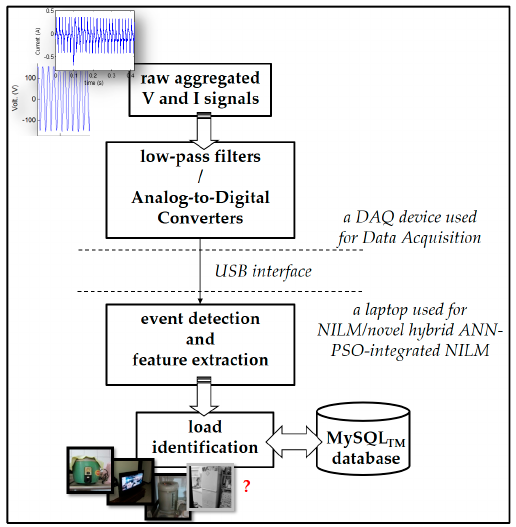
Figure 3. Workflow of the innovative hybrid ANN-PSO-integrated NILM used in the HEMS and proposed in this paper.